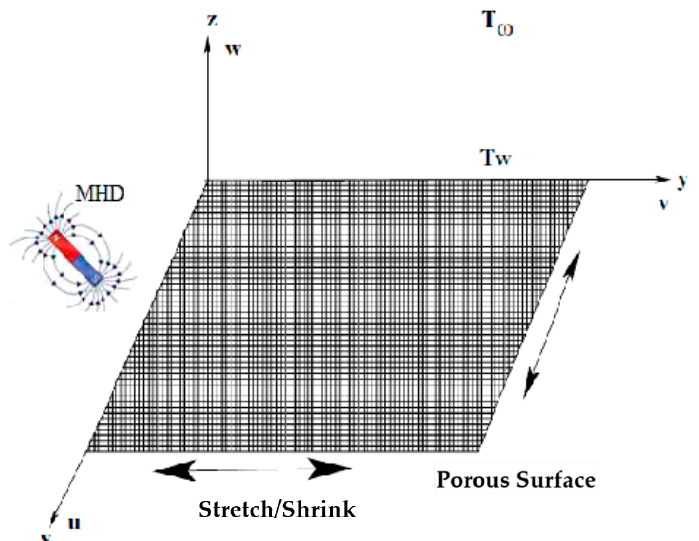
Figure 1. Schematic diagram of the three-dimensional flow.